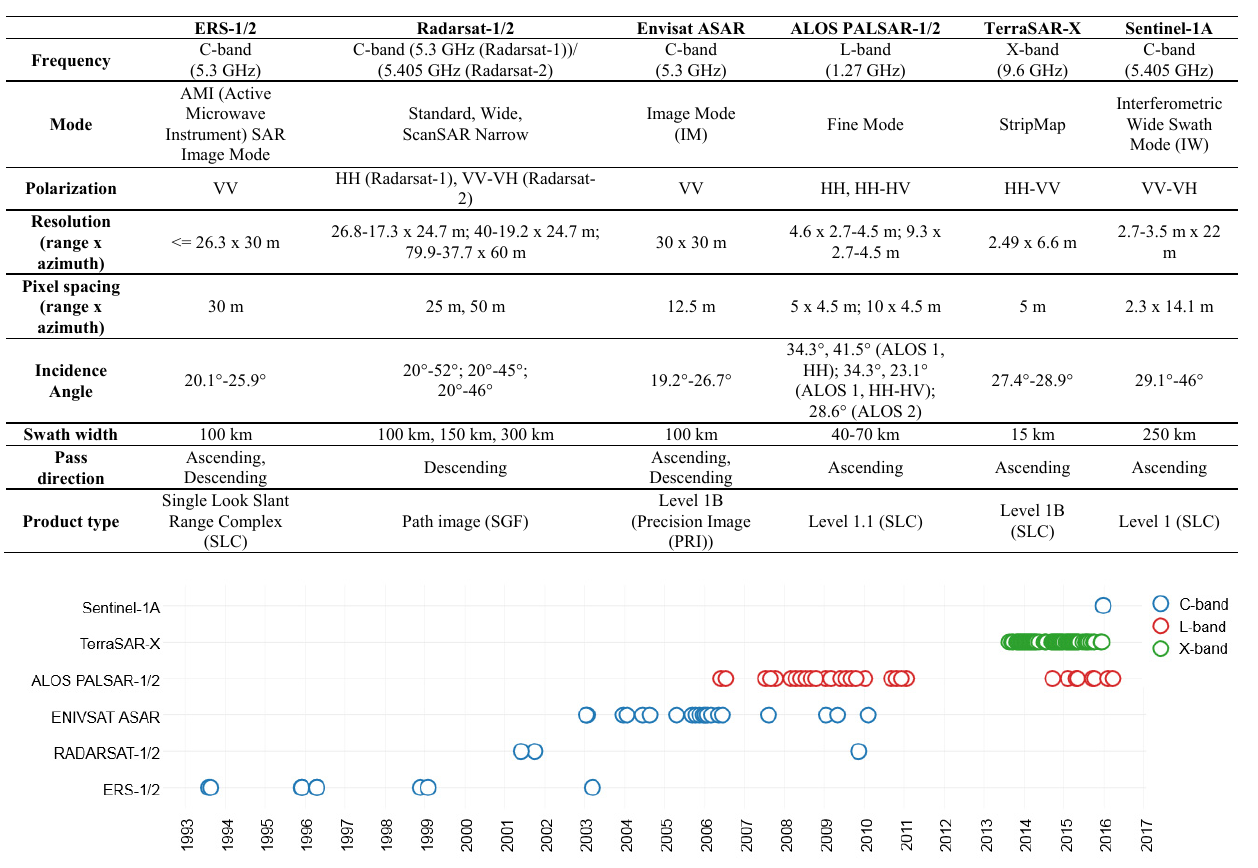
Table 1. Characteristics of the used SAR sensors.